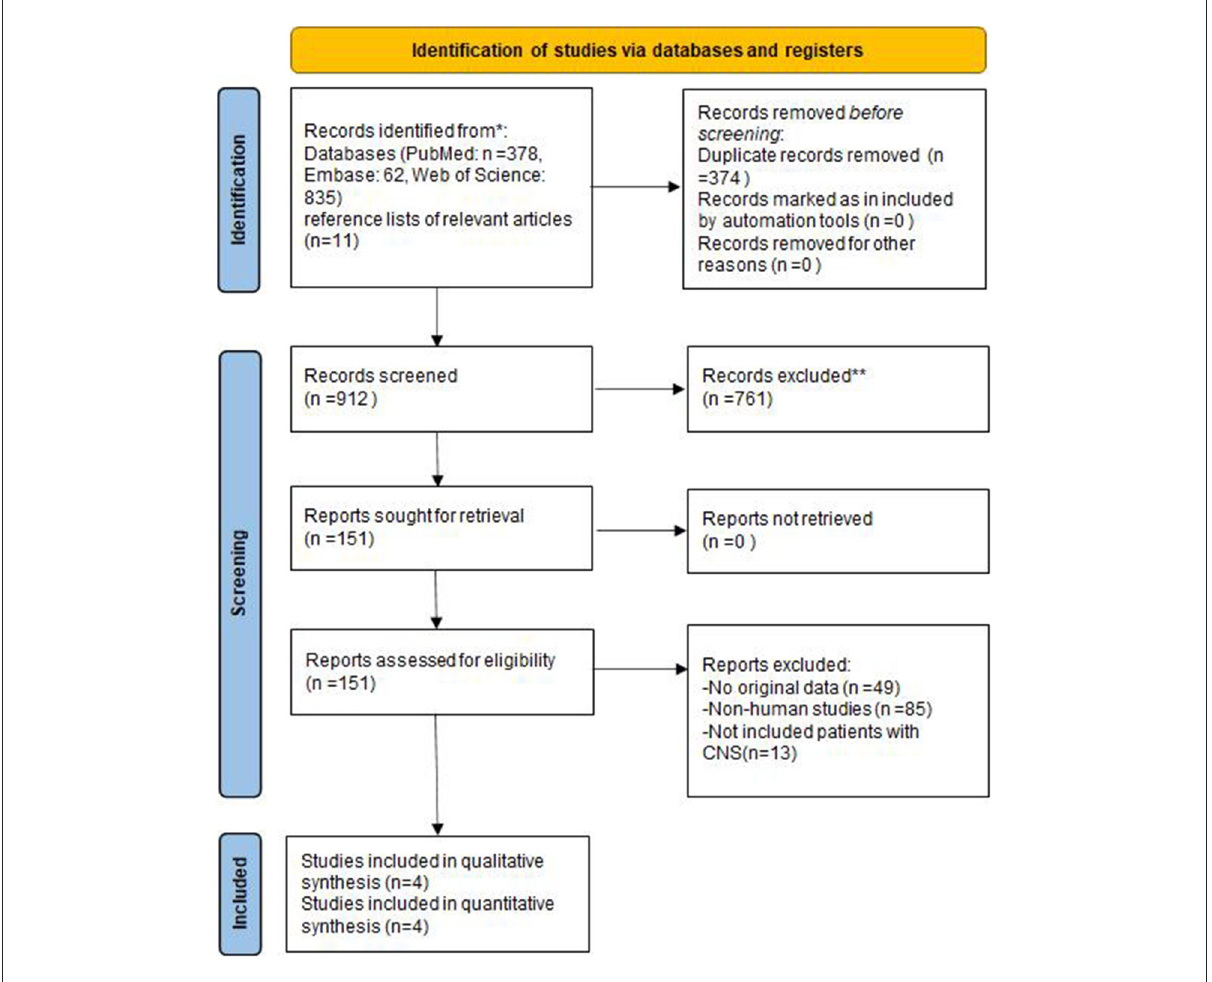
FIGURE1 Flow diagram of the study selection